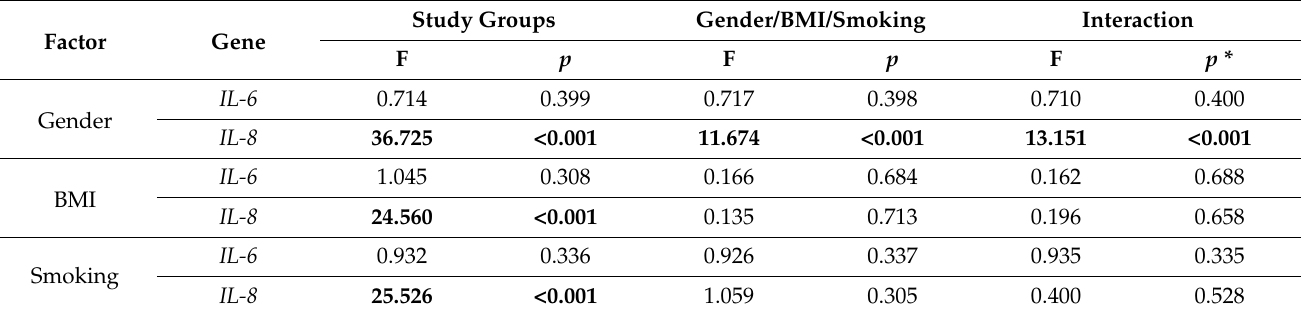
Table 3. Results of two-way ANOVA analyses on mRNA expression of IL-6 and IL-8 .